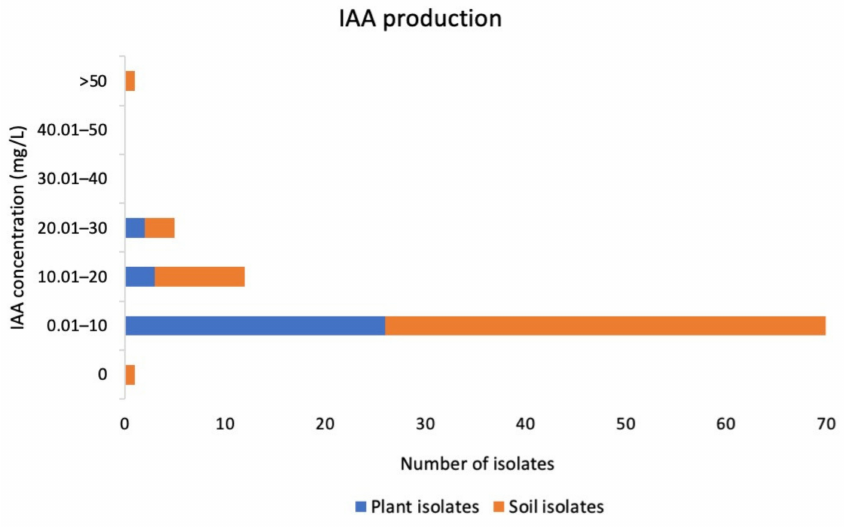
Figure 1. IAA production by actinobacteria from